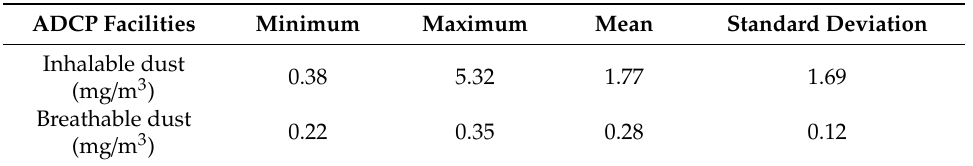
Table 6. Inhalable and breathable dust monitoring at the ADCP facilities. ADCP = anaerobic digestion plus composting plants.